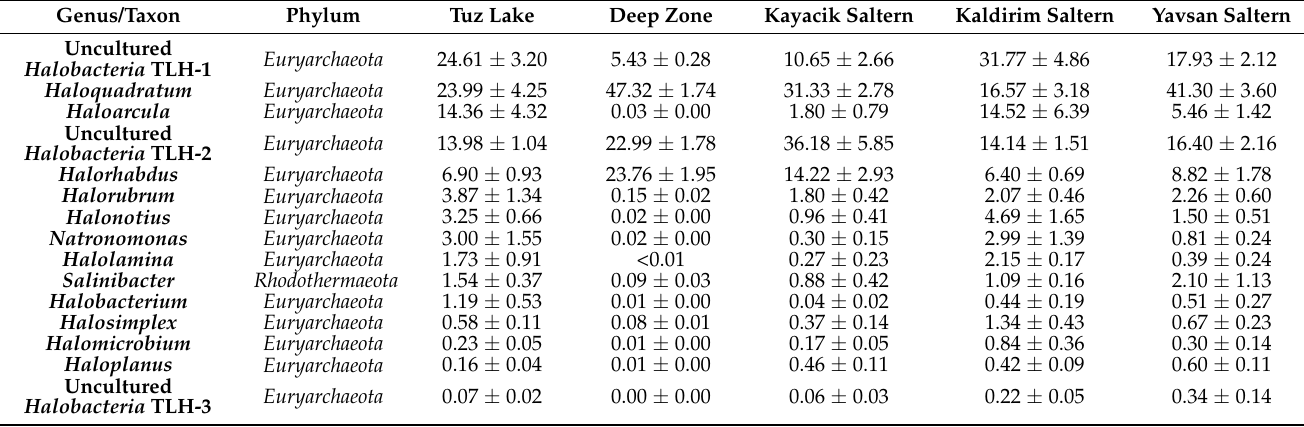
Table 2. Taxonomic distribution at the genus level, with more than 0.3% sequences detected in the brine samples collected from Tuz Lake, Deep Zone, and Kayacik, Kaldirim, and Yavsan salterns. Genus/Taxon Phylum Tuz Lake Deep